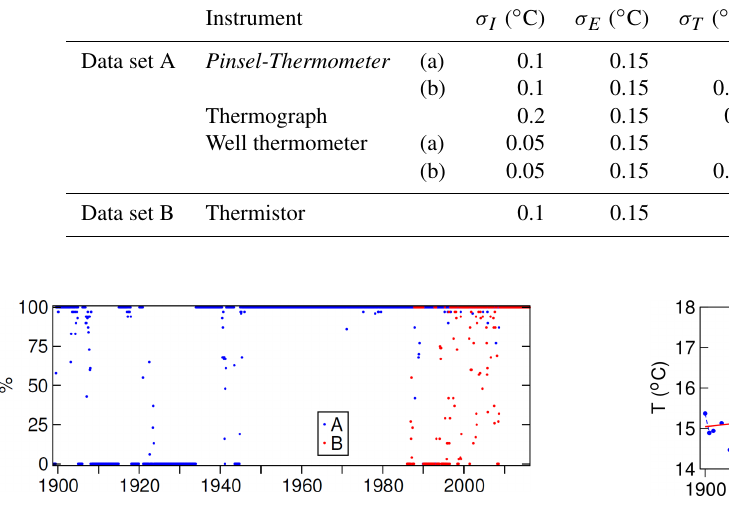
Table 2. Errors in estimated mean daily temperature. σ I is the instrumental error, σ E is the environmental error, σ T is the time-related error, σ o is the observational error, No. of obs. is the number of observations per day, σ is the error of the estimated daily mean. Labels (a) and (b) correspond to zero and non-zero uncertainties in time, respectively. When No. of obs. is characterised by a range, the corresponding σ range is shown. See Sect. 3.2 for detailed explanations.